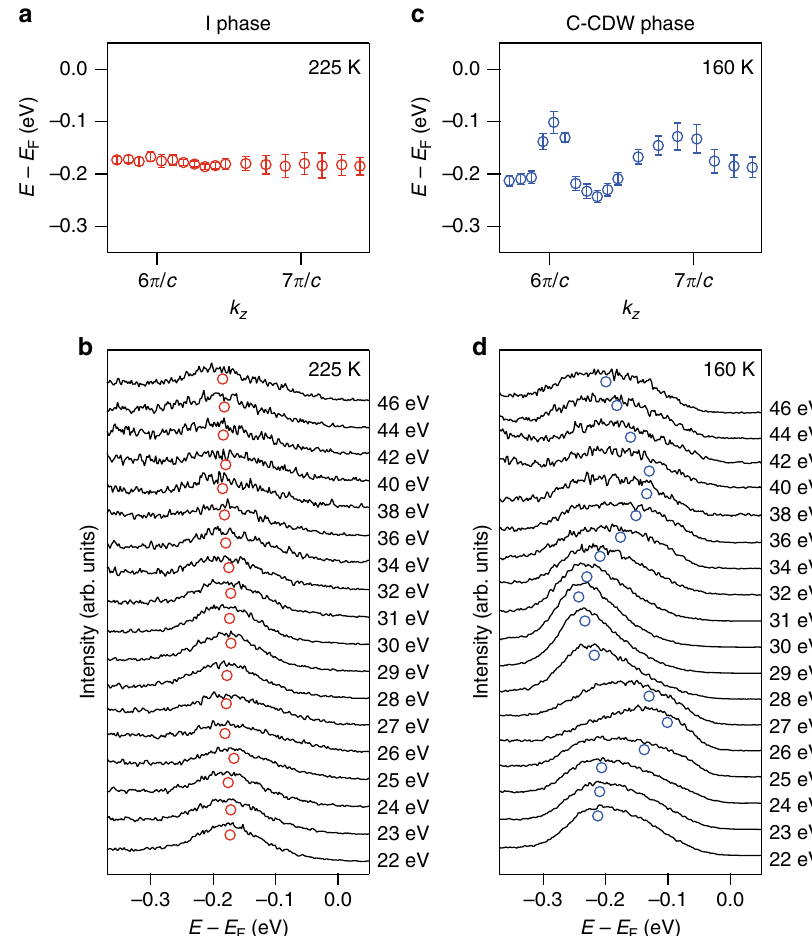
Fig. 4 Band dispersions along the k z direction taken in the I and C-CDW phases. a k z dependence of the band positions in the I phase at 225 K. k z is calculated using the inner potential V 0 = 17.5 eV. b Photon energy dependence of EDCs taken at Γ at 225 K. c and d are the same as a and b but taken in the C-CDW phase at 160 K. Red and blue circles are the fi tted band positions. Error bars are estimated from peak fi ttings and de fi ned as